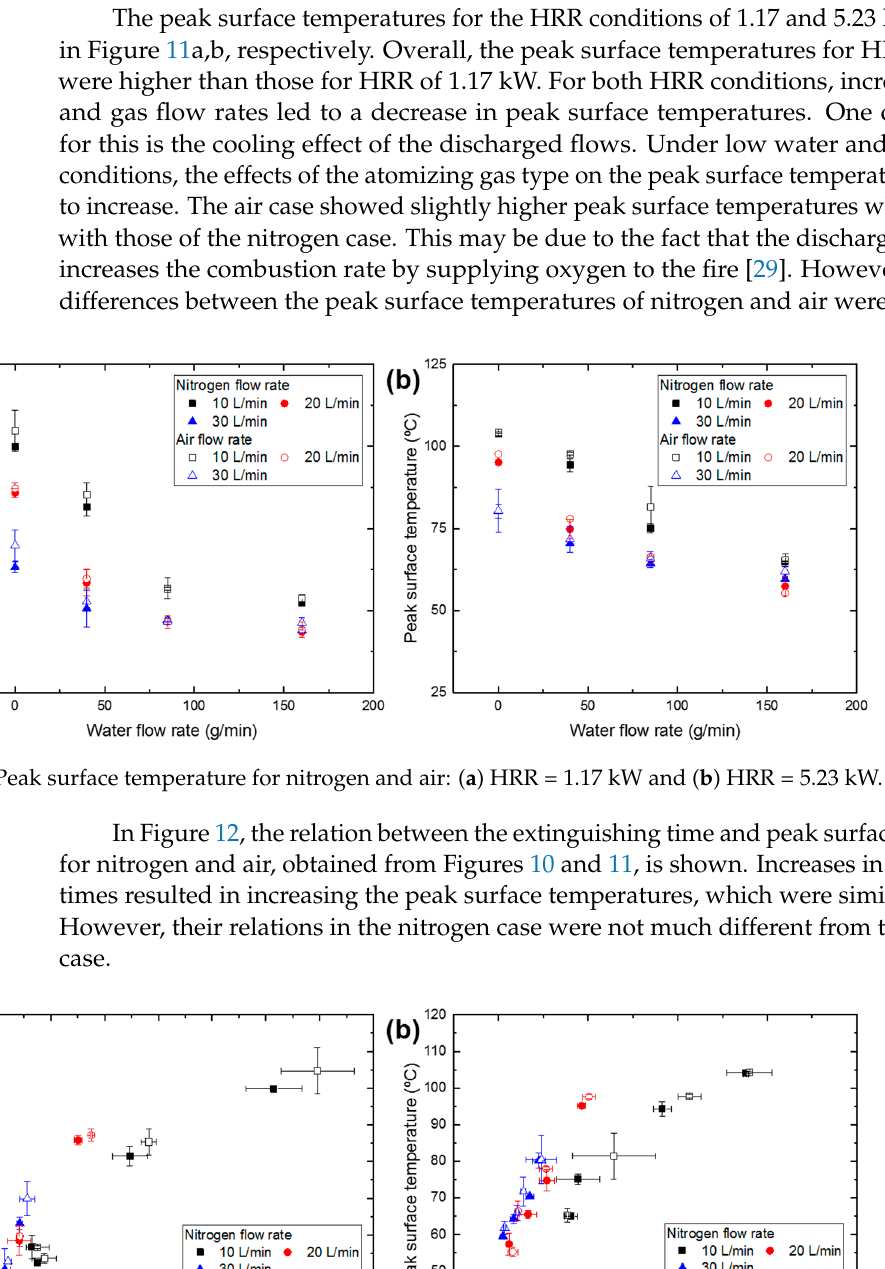
Figure 10. Extinguishing time for nitrogen and air (note that the scales of y -axis in both figures are different): ( a ) HRR = 1.17 kW and ( b ) HRR = 5.23 kW.